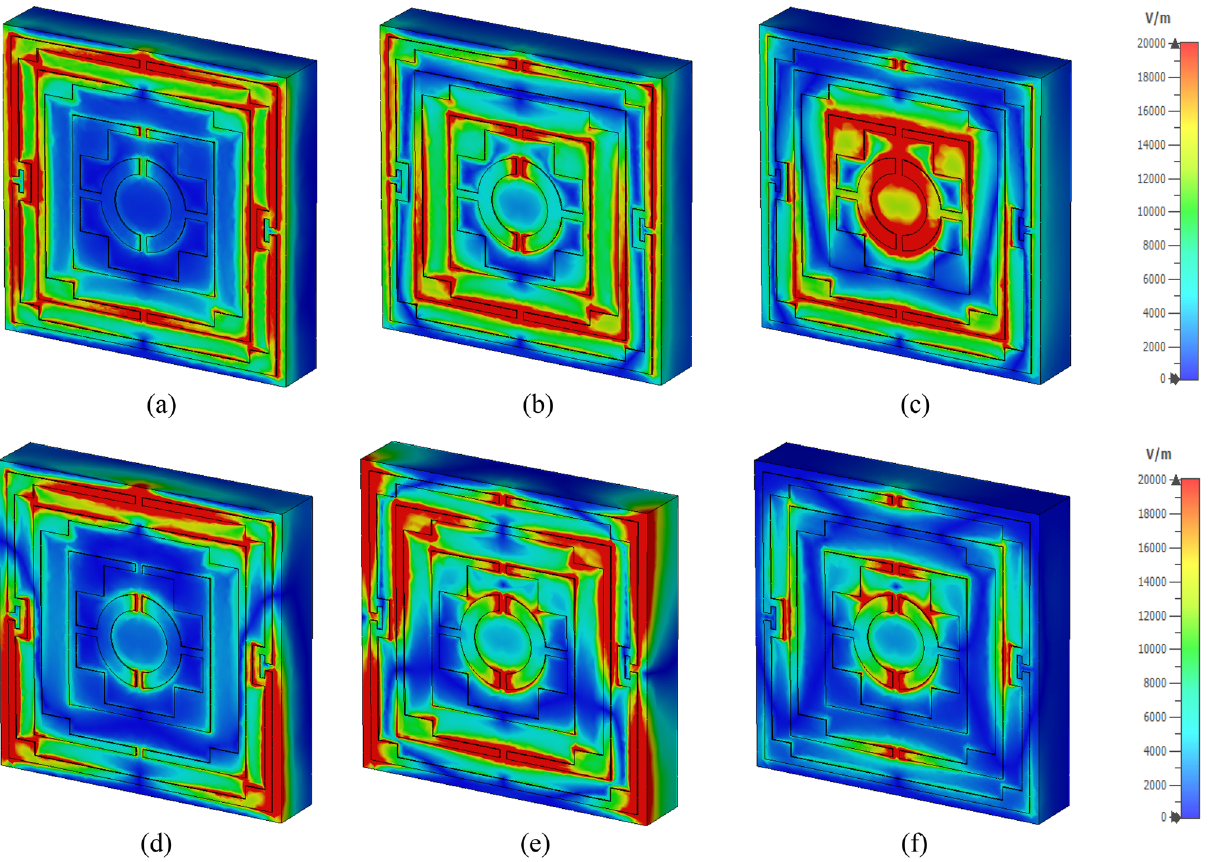
Figure 6. E field distribution of the proposed unit cell: ( a ) 2.38 GHz, ( b ) 4.24 GHz, ( c ) 5.98 GHz, ( d ) 9.55 GHz, ( e ) 12.1 GHz, and ( f ) 14.34